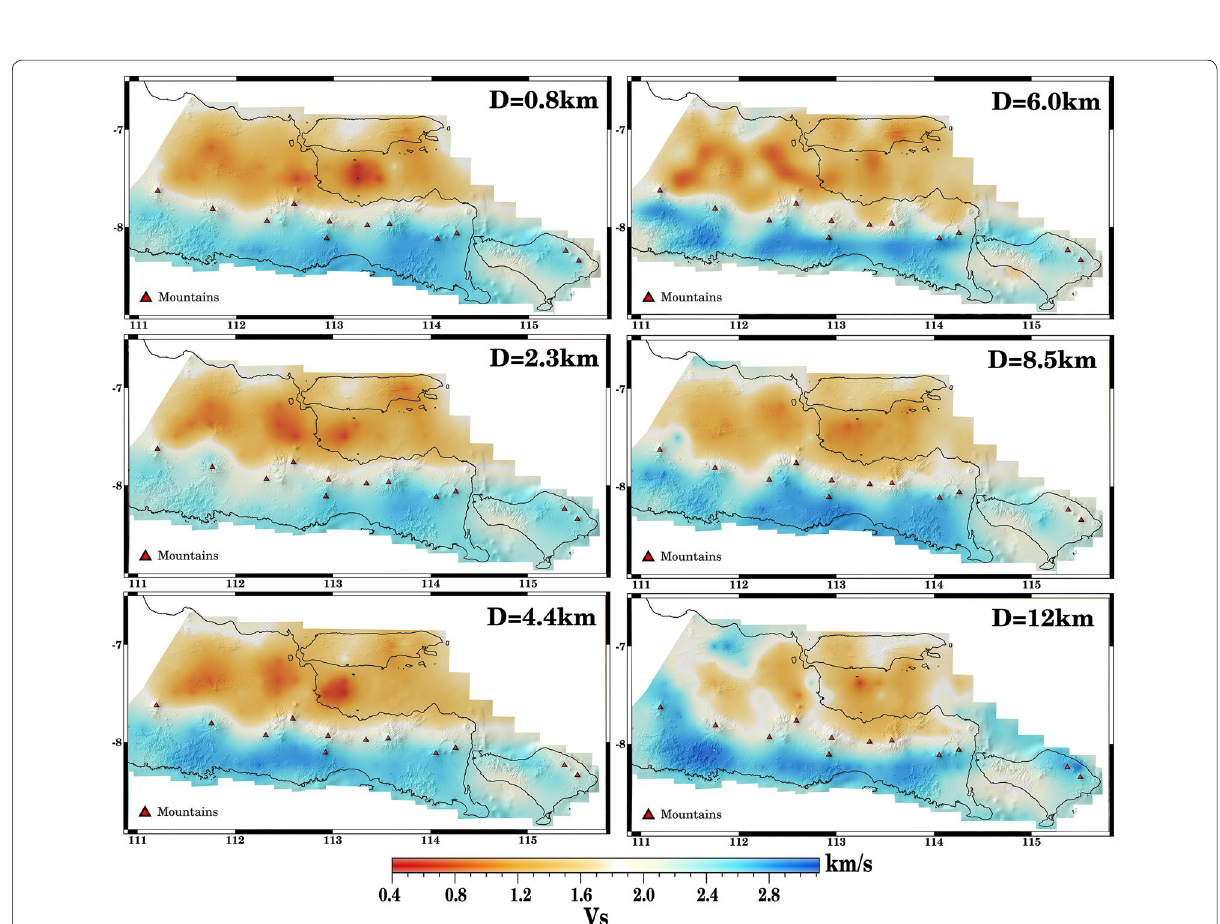
Fig. 8 Shear wave velocity slices across East Java and Bali from the Neighborhood Algorithm inversion of group velocity dispersion